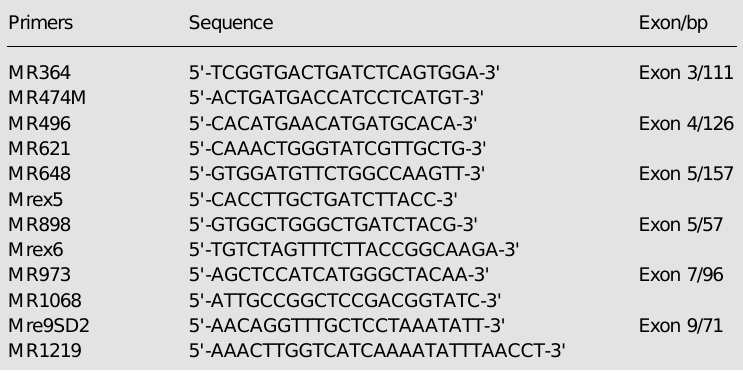
Table 3. Primers used for identification of the RHD Ψ 37-bp insert.